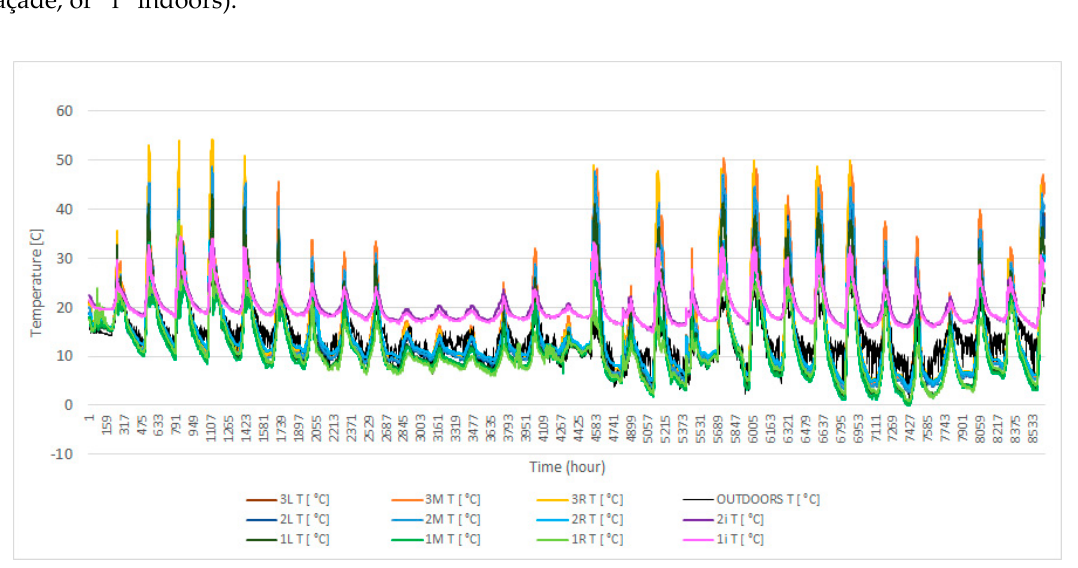
Figure 2. Outdoor, indoor and façade temperatures registered from 5 November to 5